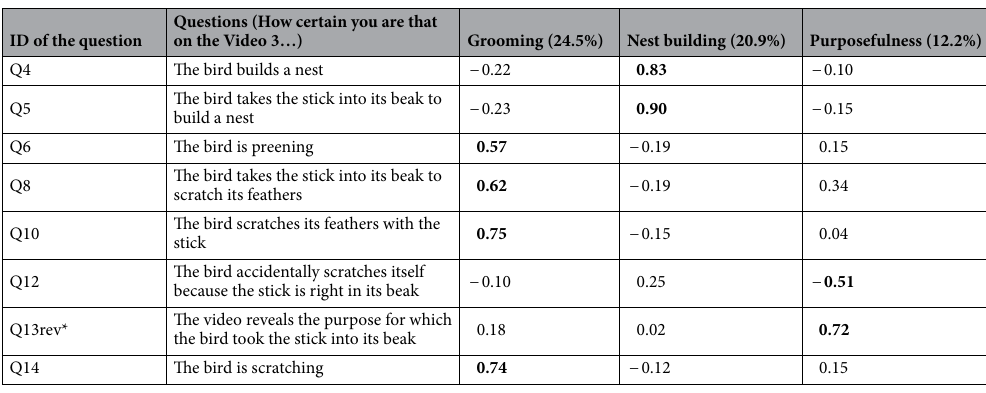
Table 1. The factor structure of the behaviour evaluation questionnaire (BEQ) after varimax rotation. The labels of the factors were chosen based on the loading of items, and the proportion of the total variance explained by these factors are shown in parentheses. Loadings greater than 0.30 are highlighted in bold. * Note that the Q13rev was originally a negative-wording question that we reversed the values of the answers before performing the statistical analyses. The original statement was: “The video does not reveal the purpose for which the bird took the stick into its beak”